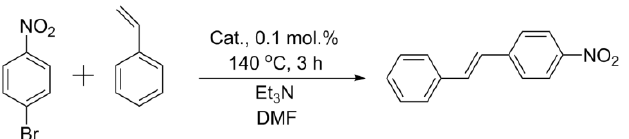
Table 3. Reaction of p-nitrobromobenzene with styrene in the presence of prepared